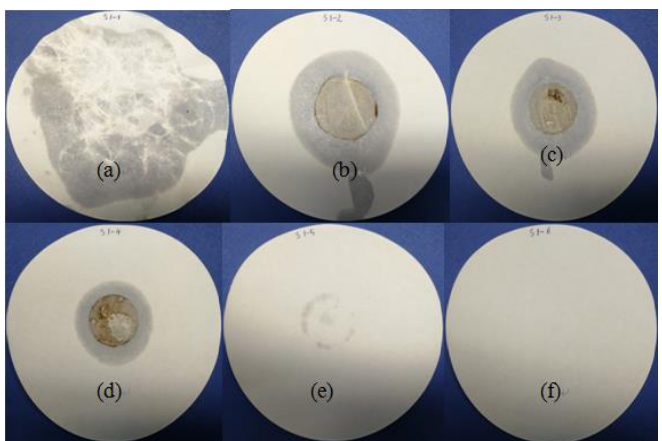
Figure 4. Liquid stains of CA in CA/CIT composites on the filter paper after heating at 60 °C. ( a ) S1-1,